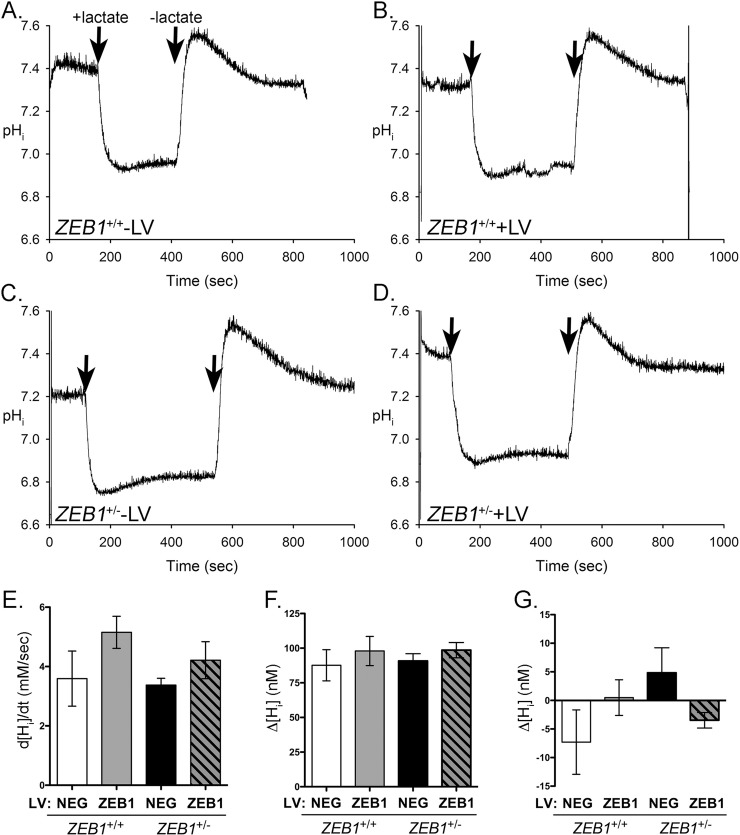
ZEB1 insufficiency does not affect the CEnC response to lactate.(A-D) Traces showing effect of lactate exposure on intracellular pH (pHi) in the CEnC lines. Note that lactate is co-transported across the membrane with protons. pHi was calculated from fluorescence measurements of cells pre-loaded with the fluorescent pH indicator BCECF. A resting pHi was established before perfusion with lactate (20mM). Arrows indicate addition or removal of lactate. (E) Bar graph showing the maximum change in intracellular proton concentration ([Hi], nM) per second (d[Hi]/dt) after addition of lactate. (F) Bar graph showing the mean of the difference between resting [Hi] and minimum [Hi] achieved after addition of lactate. (G) Bar graph representing the mean of the difference between the pre-lactate resting [Hi] and the post-lactate resting [Hi]. Data in E-G were represented as the mean ±SEM (n = 3). Comparisons in E-G were performed using one-way ANOVA with post-hoc Tukey test. No statistically significant differences were identified.